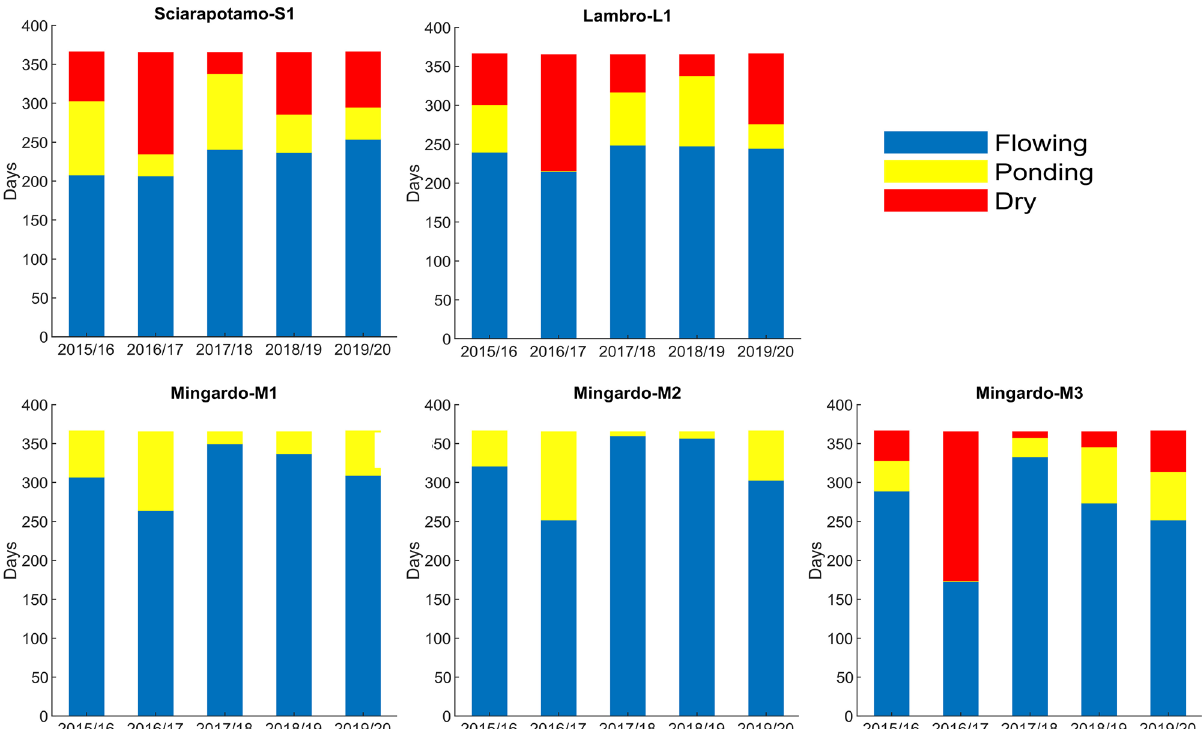
Figure 8. Daily occurrences of flowing (blue), ponding (yellow) and dry (red) phases predicted by the individual RF models for each reach during the study period from 2015 to